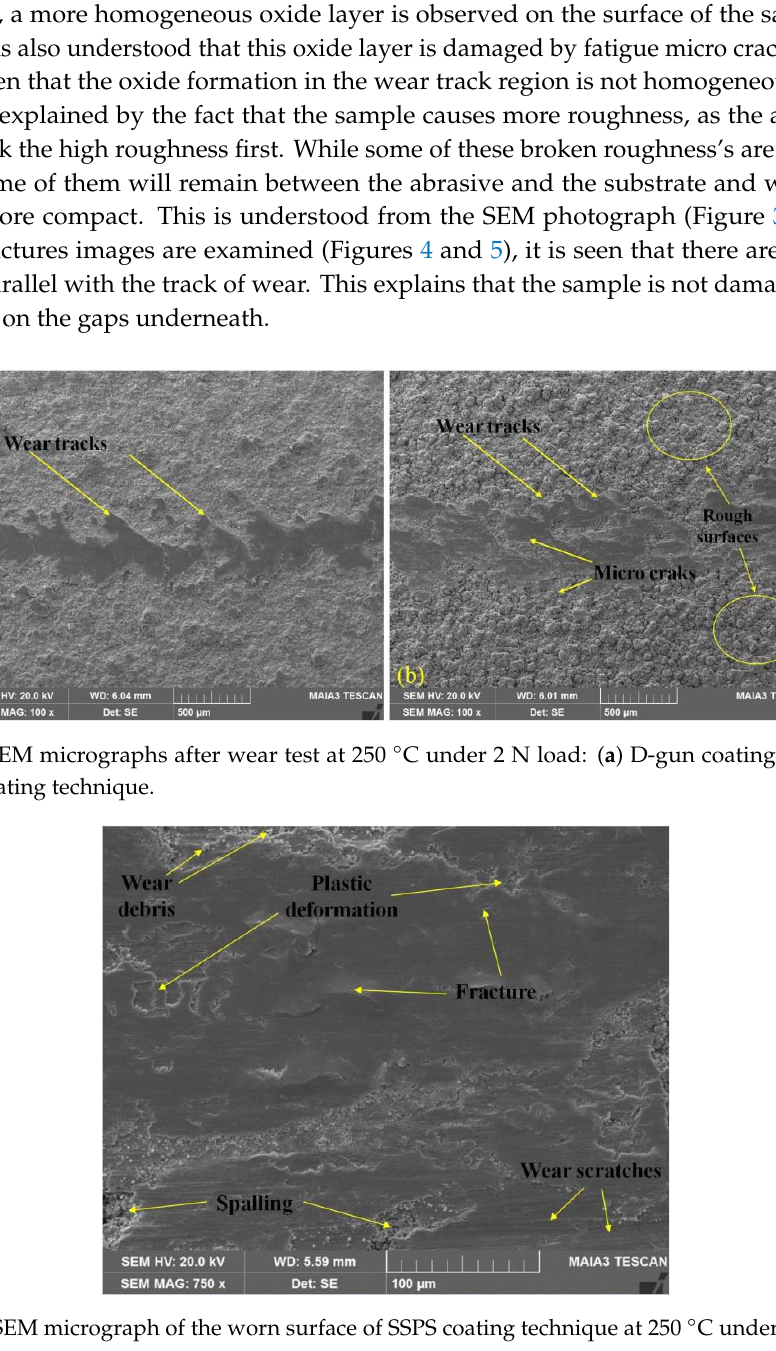
Figure 4. SEM micrograph of the worn surface of SSPS coating technique at 250 °C under 2 N load.